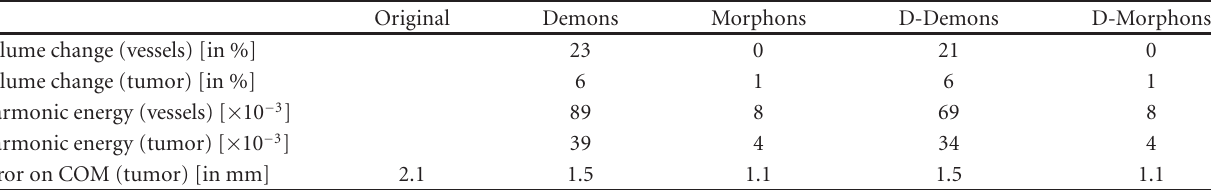
Table 3: Comparison of volume change, harmonic energy, and errors in center of mass of the delineations of the vessels and tumor on a single phase.